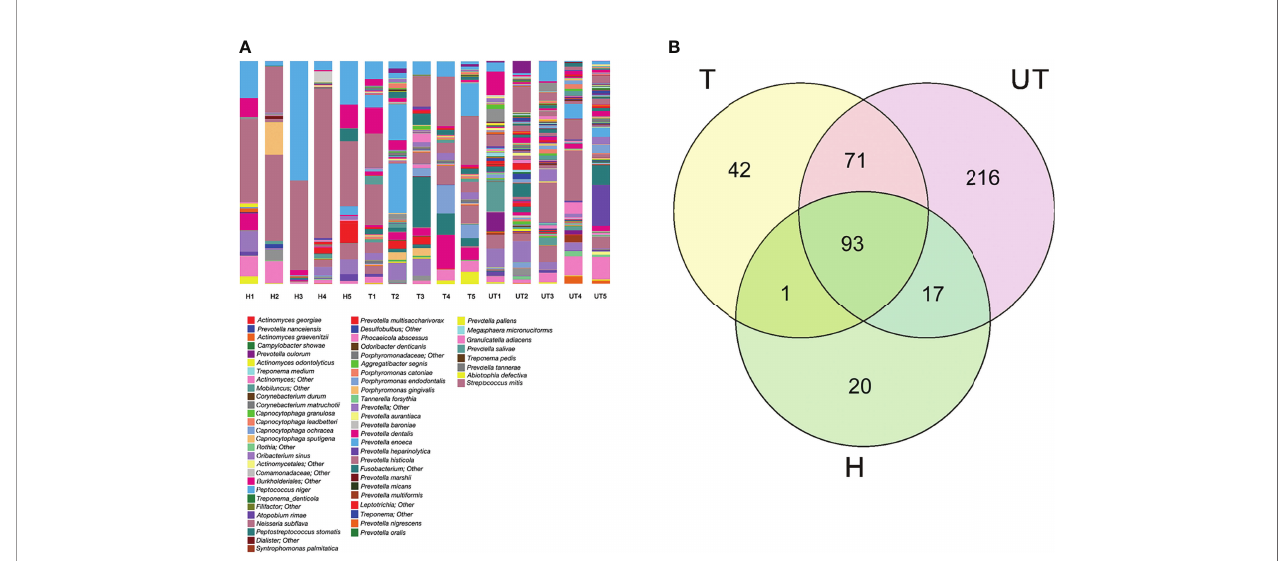
FIGURE 4 | Distribution of saliva sample fl ora species in HIV-infected/AIDS patients after HAART. (A) The proportion of different species was displayed using the species pro fi ling in each sample. (B) Venn diagram showed the overlap and differences in the composition of salivary microecological communities of different groups.